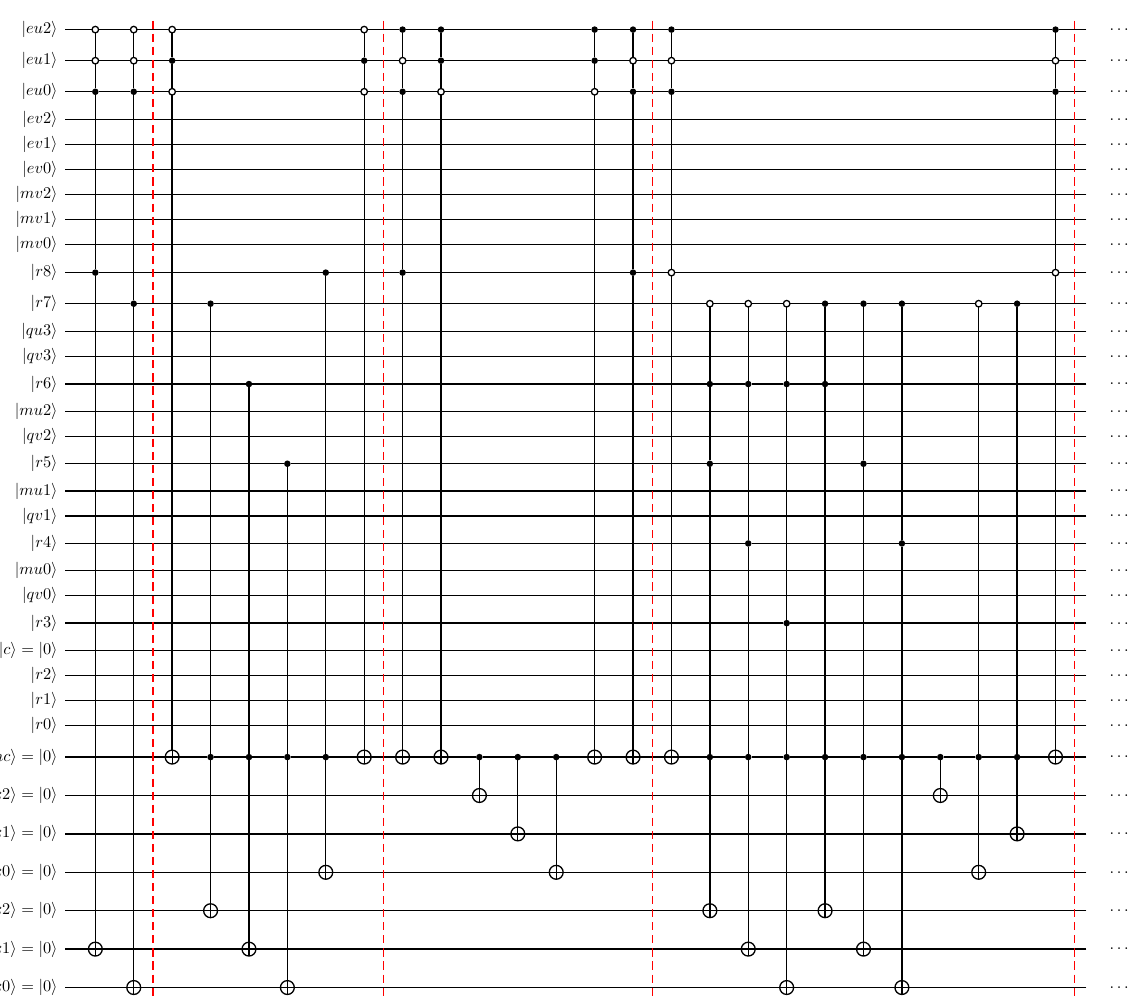
Figure 17. The possibility of overflow for flow for Figure 16.